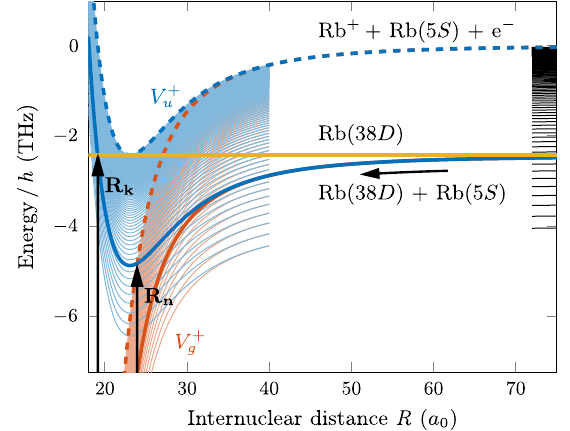
FIG. 6. Potential energy curves relevant to the formation of Rb þ 2 for Rydberg states from 30 D to the ionization threshold. For each ð R Þ Rydberg state, there are two PEC attached, namely, V þ u showing a primarily repulsive nature, whereas the other labeled ð R Þ displays a far more attractive nature that supports many V þ g bound states. The dark blue line represents the potential curve ð R Þ , which correlates with the 38 D state, and the crossing point V þ u PEC correlates with the onset where of this potential with the V þ g autoionization can begin into the channel Rb þ 2 þ e − (red dashed represents the outer boundary of the line). This crossing point R n associative ionization region. The inner boundary of this auto- ionization region ends at the inner turning point R , where the k collision energy (solid orange line) is equal to the Fig. 6. Attached to this Rydberg state are the V þ and V þ g u